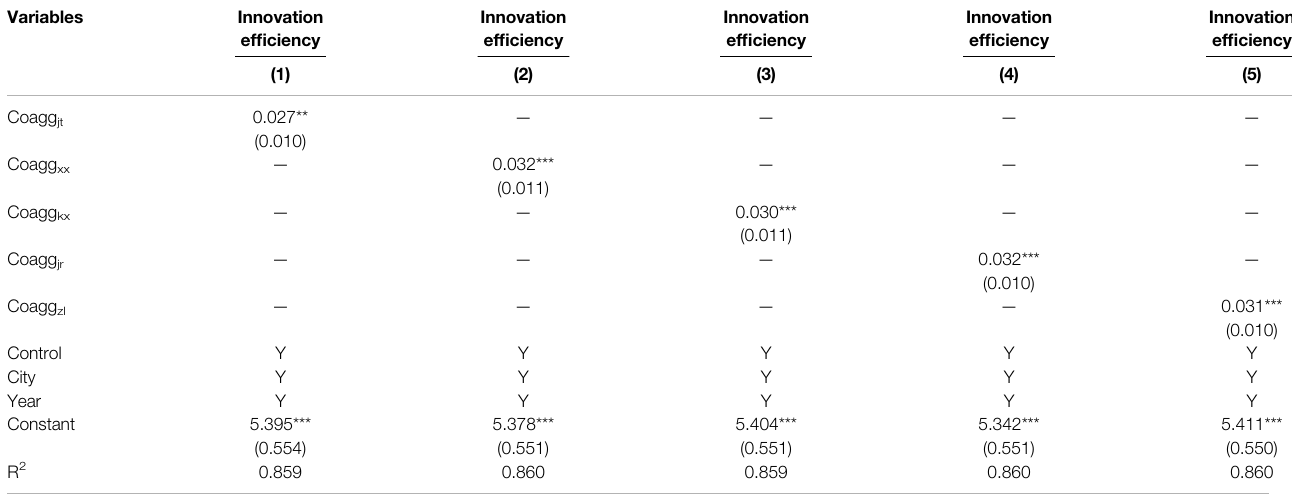
TABLE 5 | Regression results of distinguishing industrial collaborative agglomeration types.